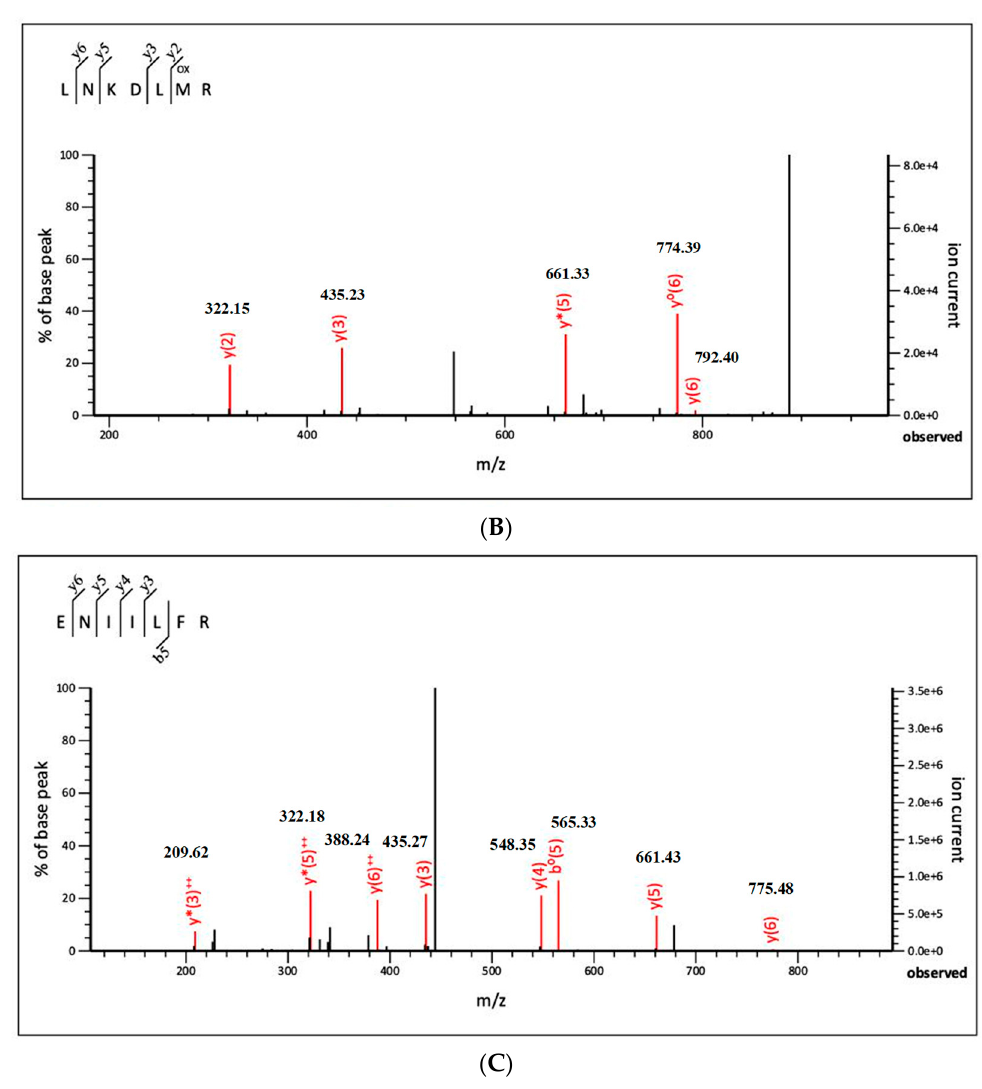
Figure 3. The second mass spectrogram of the identified peptides. ( A ) Mass spectrum analysis of the antioxidant peptide Met-Ley-Ile-Ile-Ile-Met-Arg. ( B ) Mass spectrum analysis of the antioxidant peptide Leu-Asn-Lys-Asp-Leu-Met-Arg. ( C ) Mass spectrum analysis of the antioxidant peptide Glu-Asn-Ile-Ile-Leu-Phe-Arg.